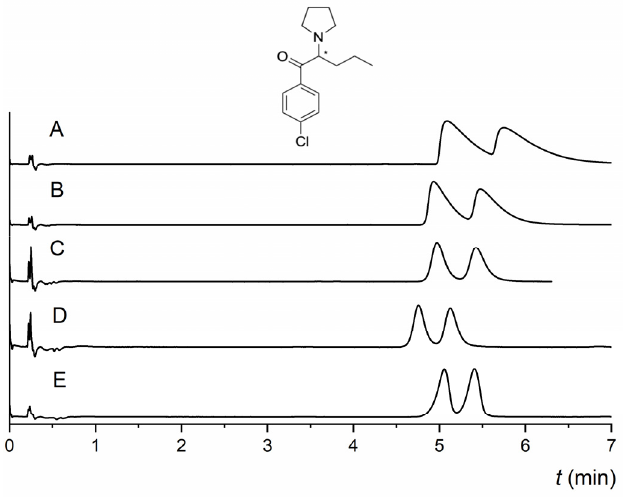
Figure 3. Effect of the amount of water as an additive on the enantioseparation of pyrovalerone (4-Cl-PVP) on the NicoShell column. MP composition: CO 2 /MeOH 80/20 ( v / v ) (A), CO 2 /MeOH/H 2 O 80/20/0.5 ( v / v / v ) (B), CO 2 /MeOH/H 2 O 80/20/1.0 ( v / v / v ) (C), CO 2 /MeOH/H 2 O 80/20/1.25 ( v / v / v ) (D), CO 2 /MeOH/H 2 O 80/20/1.5 ( v / v / v ) (E), flow rate 1.00 mL min − 1 , temperature 25 °C, BP 13.8 MPa, UV detection 254 nm. (*) in the structure indicates a stereogenic center.